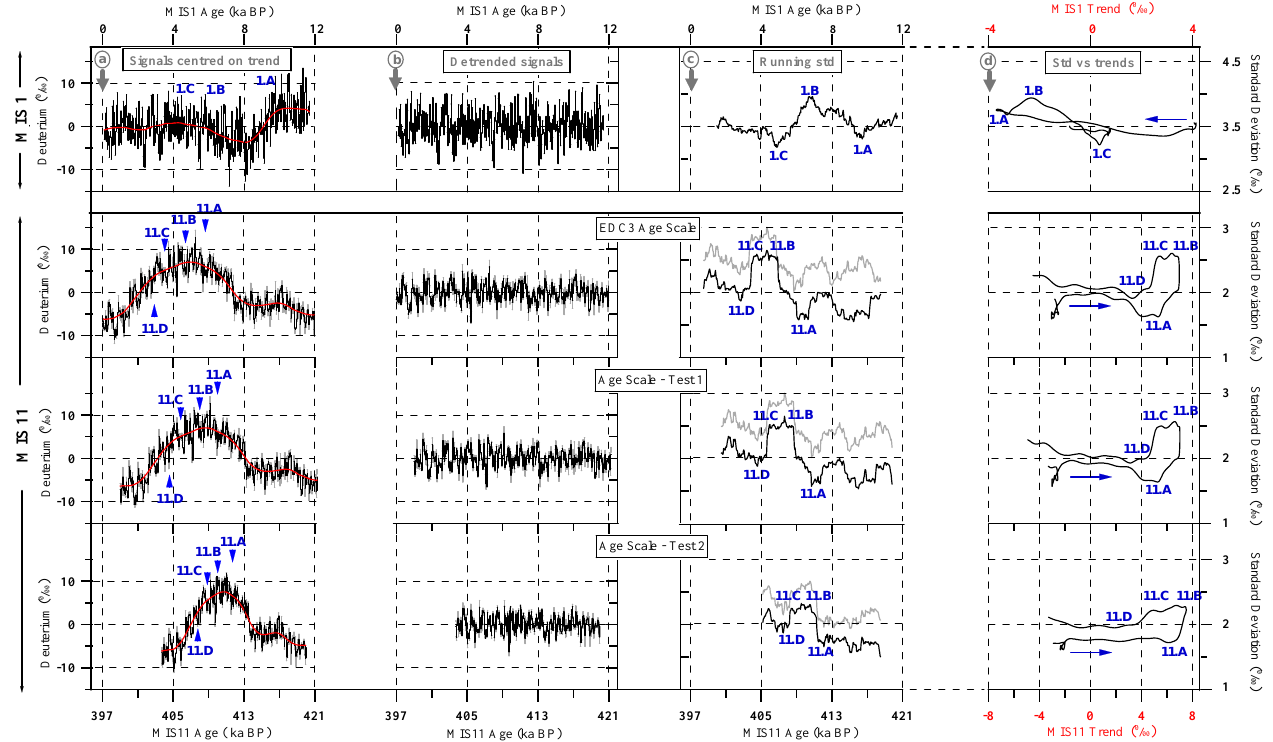
Fig. 2. Variability analysis (in ‰) of MIS 1 (top), MIS 11 using EDC3 chronology (middle top), Test 1 age-scale (middle bottom) and Test 2 age-scale (bottom). (a) Signals (black) centred on the δD mean value of the period focussed on: 0–12ka for MIS 1; 397–421ka for MIS 11 – EDC3; 399–421.3ka for MIS 11 – Test 1; 403.7–420ka for MIS 11 – Test 2. The general trends are plotted in red; signals corrected from isotopic diffusion in grey for MIS 11. (b) Signals minus their respective trends (red, panels a). (c) Calculated running standard deviation of panel b signals over 3kyr, from the past 1.5kyr to the next 1.5kyr at a given time point (black: original signals; grey: correction for isotopic diffusion). Remarkable changes of slope are labelled from A to C or D from past to present (the 1 or 11 numbers refer to the studied interglacial). (d) Running standard deviation (panels c, ‰) plotted in the function of the respective general trends (panels a, red, ‰). Signals are smoothed using a binomial algorithm for an easier readability. The labelled points (panels c) are reported and arrows indicate the way of reading from past to